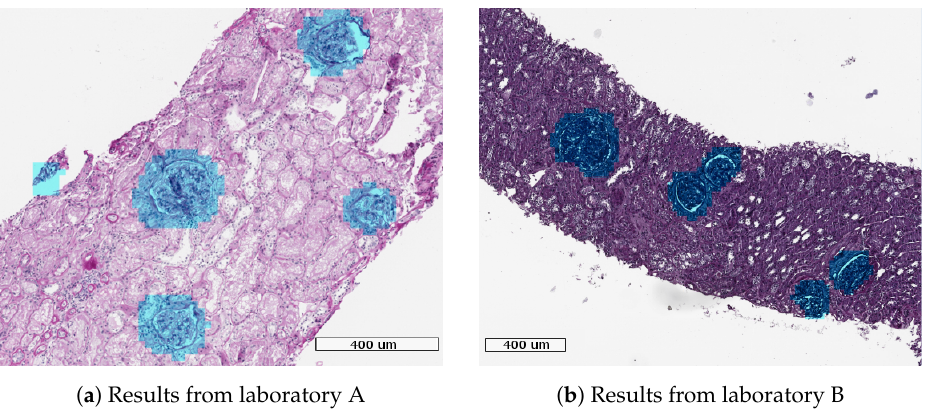
Figure 9. Results obtained in two WSI (Whole Slide Images) created in different laboratories. Regions detected as Glomerulus appear in blue color.